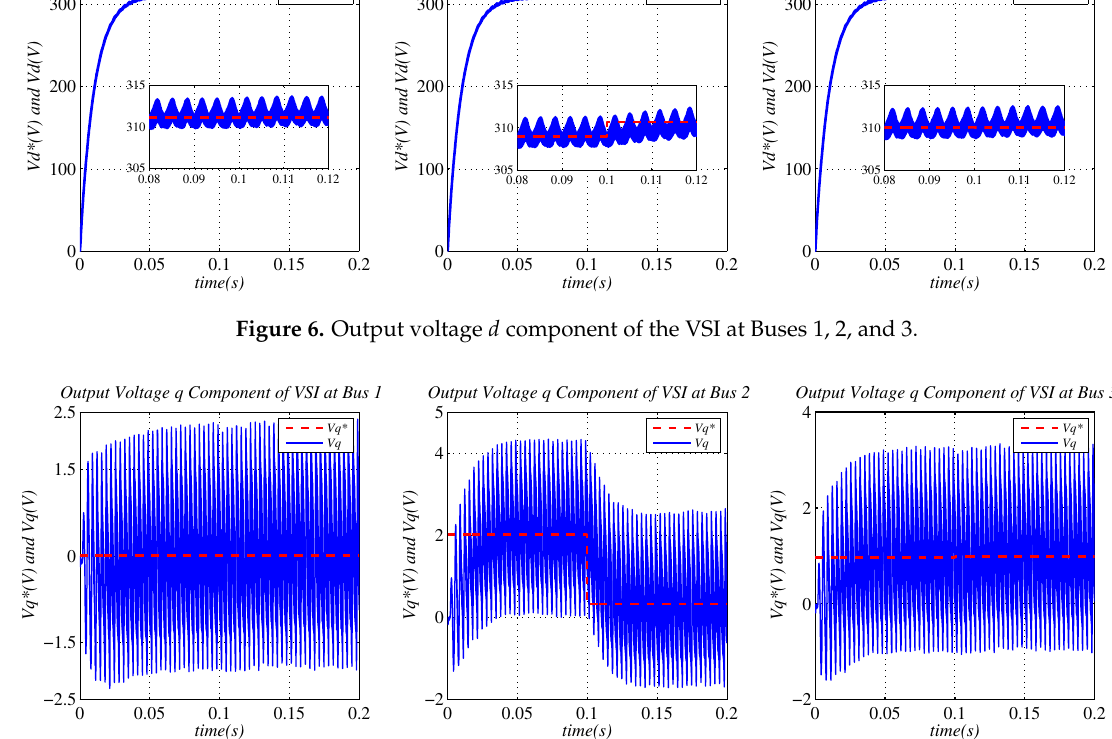
Figure 7. Output voltage q component of the VSI at Buses 1, 2, and